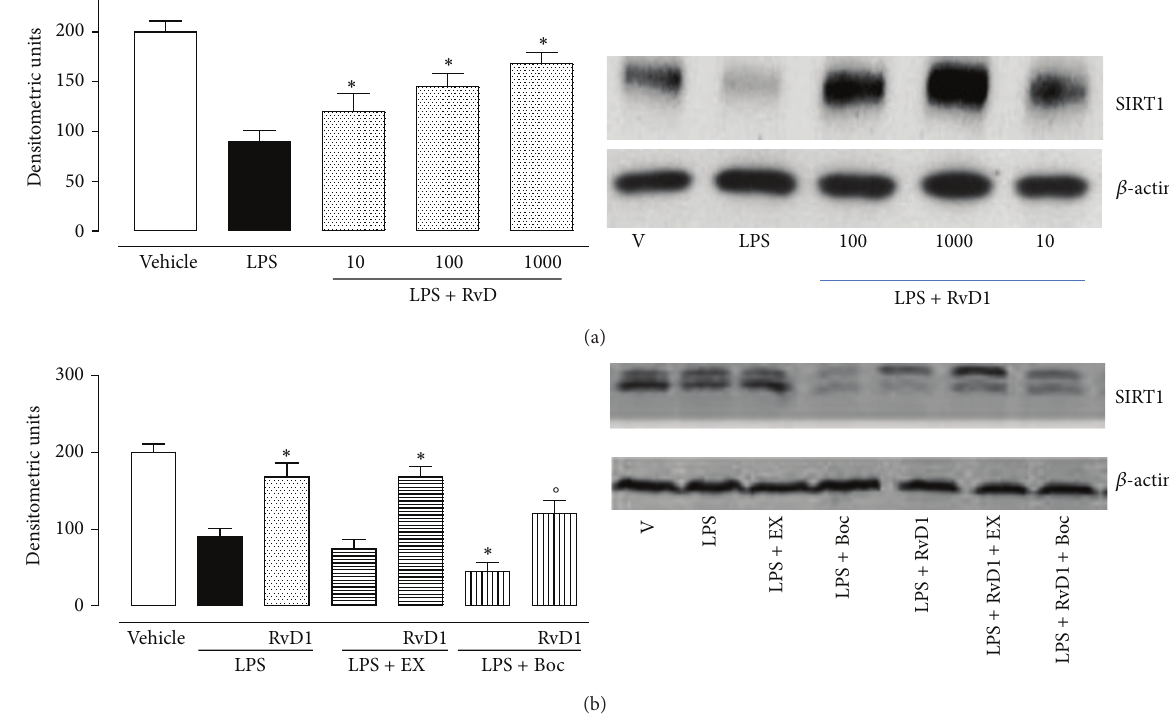
Figure 2: Local expression of SIRT1 following intravitreal resolvin D1 (RvD1). (a) SIRT1 expression evaluated by western blotting in the eyes of vehicle, LPS-treated rats, and LPS + RvD1 (10–100–1000 ng/kg) treated rats. (b) SIRT1 expression after EX-527, inhibitor of sirtuin-1 activity, and Boc2, FPR2/ALX receptor antagonist, in LPS and LPS + RvD1 (1000 ng/kg) rats. Results are expressed as densitometric units and represent the mean ± S.E.M. of 6 observations for each group. Significant differences with the LPS group are shown as ∗ 𝑃 < 0.05 and ∗∗ 𝑃 < 0.01 , while differences versus LPS + RvD1 1000 ng/kg groups are shown as ∘ 𝑃 < 0.01